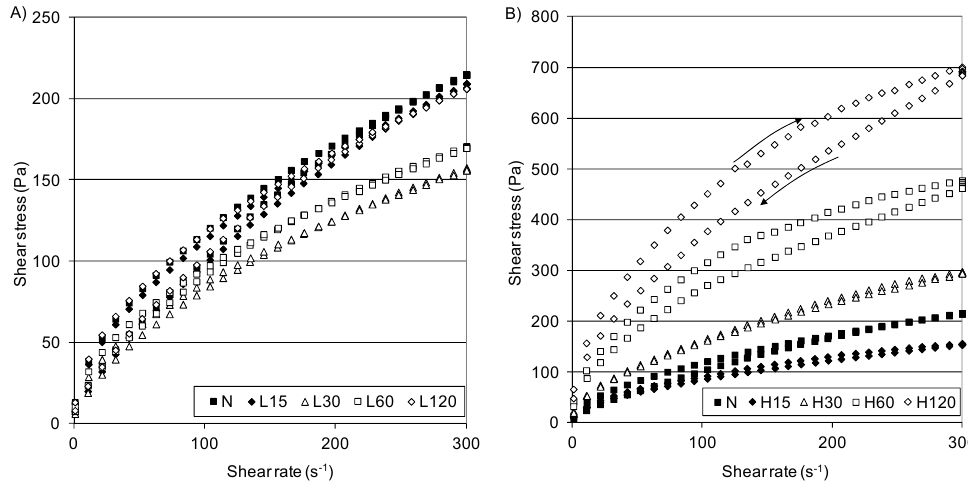
Figure 2. Flow curves of native starch and distarch phosphate pastes: ( A ) L-starches, ( B ) H-starches.